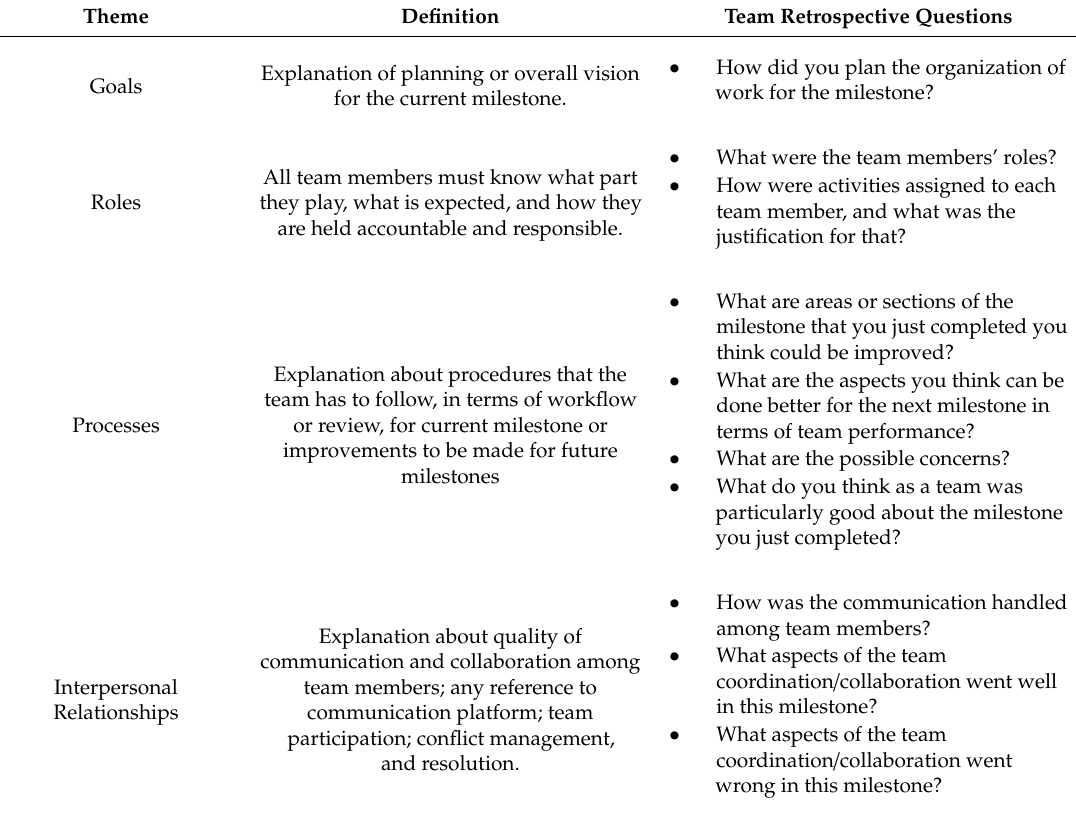
Table 1. The link between the Goals, Roles, Processes, and Interpersonal Relations (GRPI) model and team retrospective